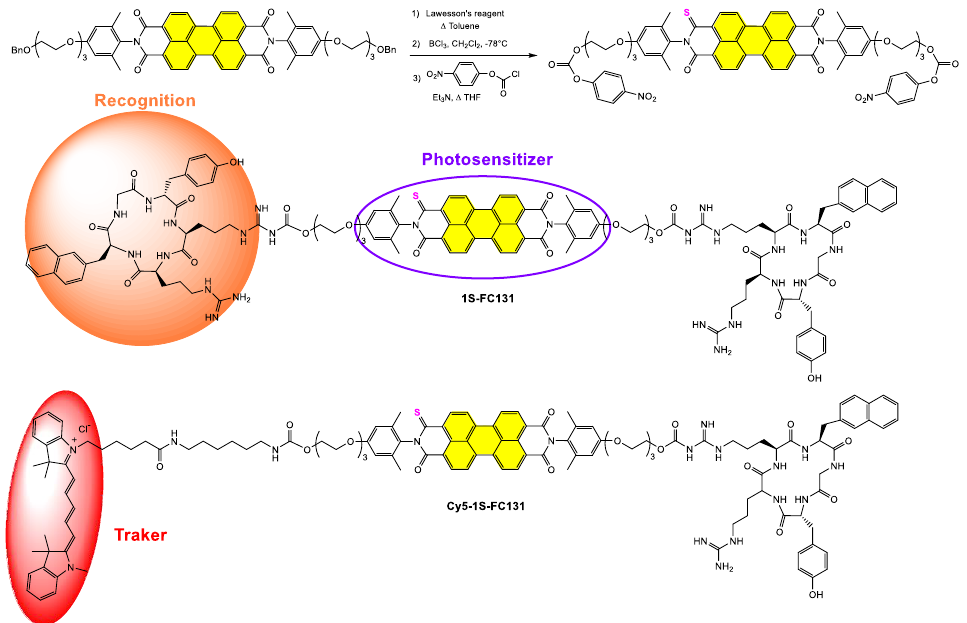
Figure 5. Structures of thiono-PDIs; corresponding UV-Visible spectra. Reprinted with permission from reference [100]. Copyright 2022 American Chemical Society.